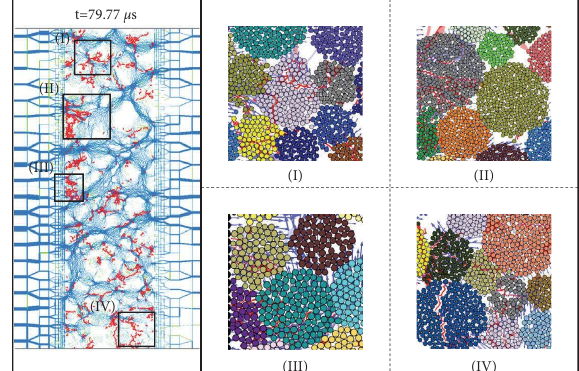
Figure 12: Breakage mode of the sand specimen during the nu- merical compression test (stage